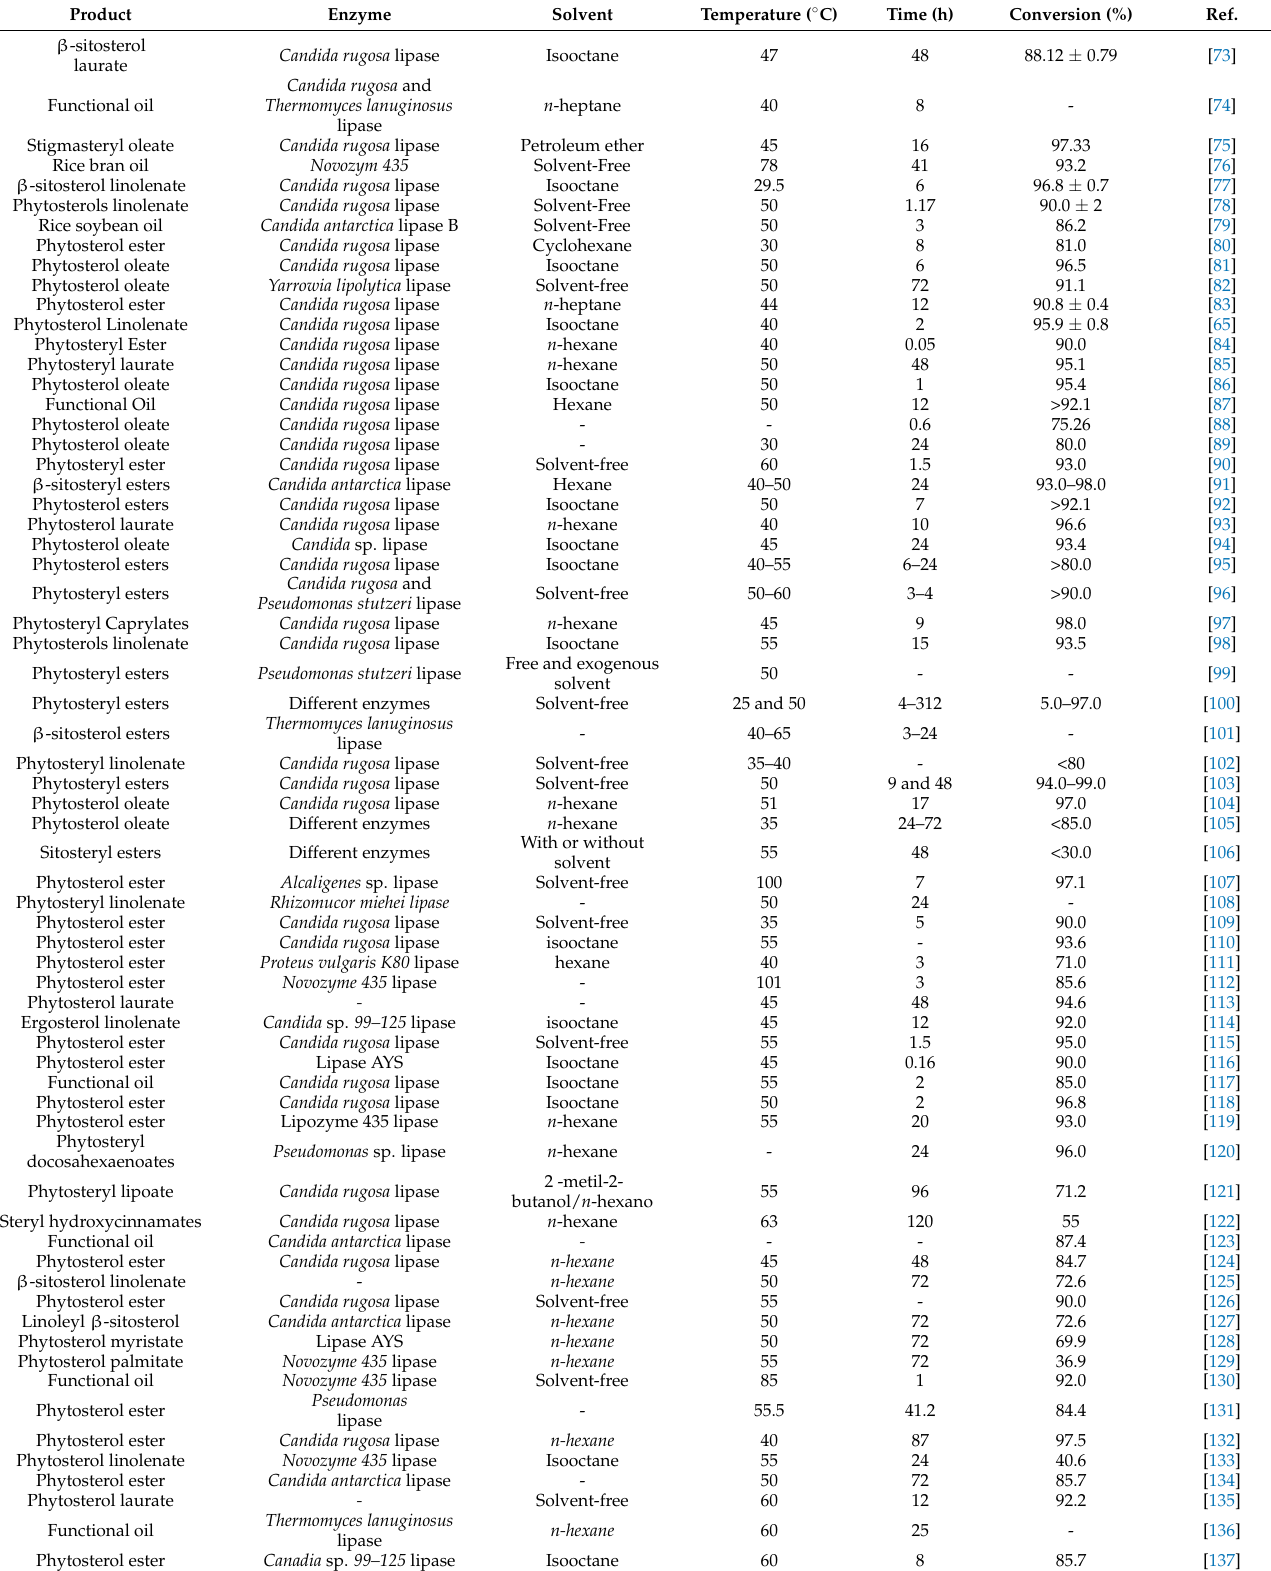
Table 1. Synthesis of phytosterol esters using enzymatic